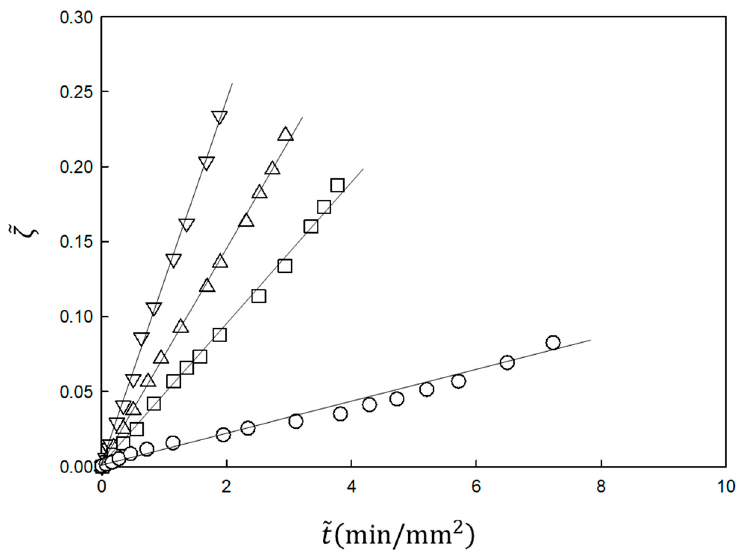
Figure 3. Time course of gel thickness obtained using the function ζ given by Equation (22) [30] for the data in Figure 2. ζ is proportional to (cid:1872)̃ , as predicted by Equation (21).